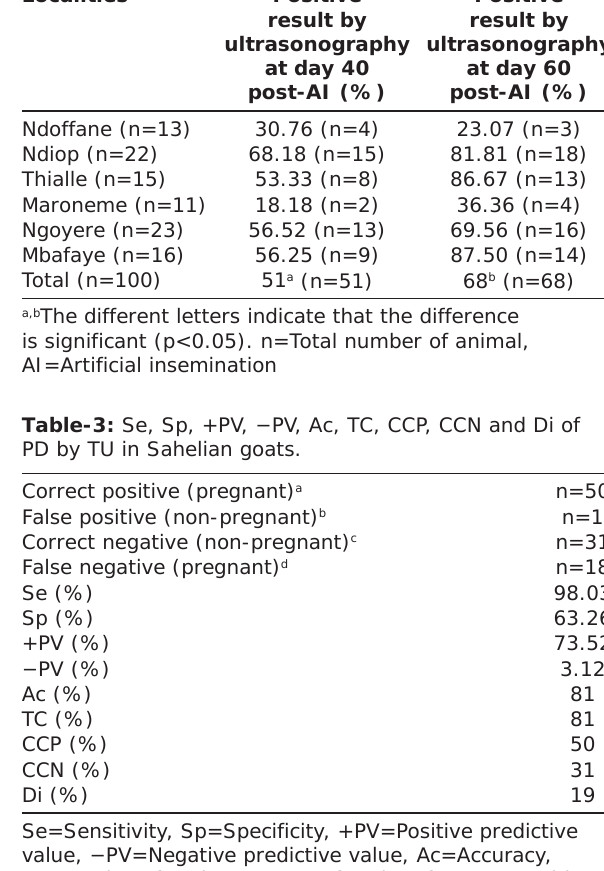
Table-2: Ultrasonographic results at day 40 and day 60 post-AI. Localities